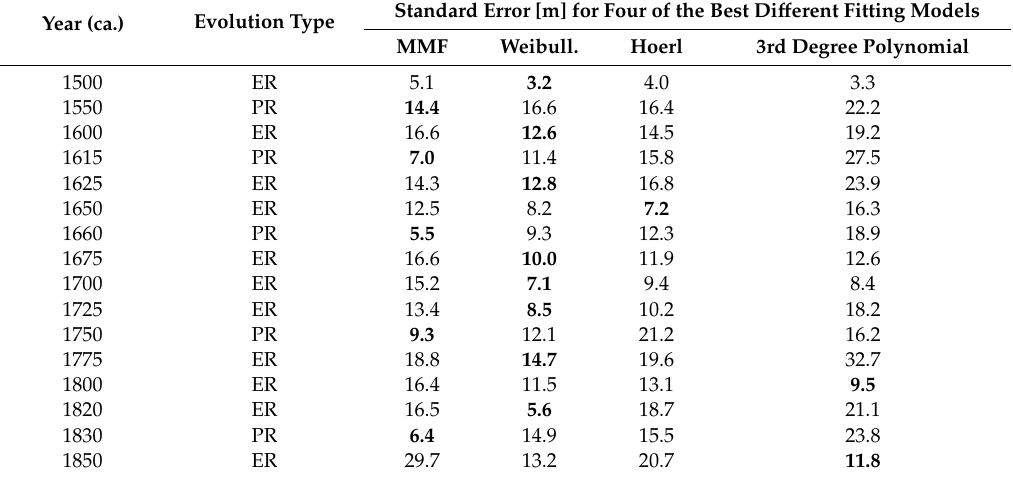
Table 1. Relation between beach ridge and best four fitting mathematical functions. ER = apex erosion, PR = apex progradation. In bold, the best standard error for each